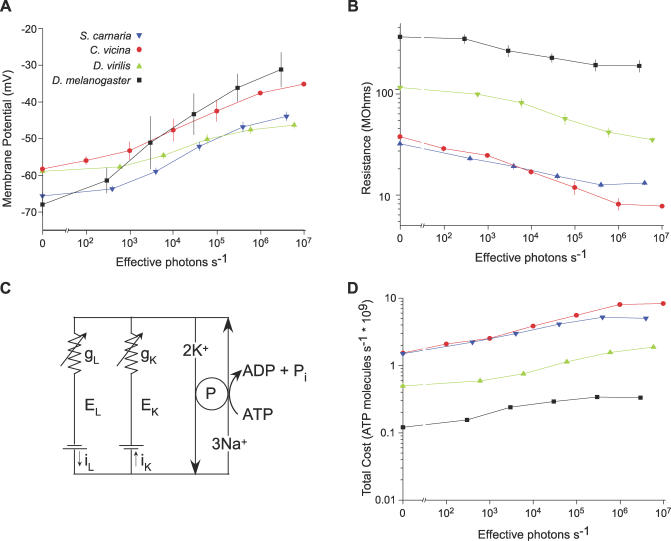
Measurements of Photoreceptor Membrane Properties Allow the Calculation of Metabolic Cost(A) The membrane potential (mean ± standard error of the mean) of R1–6 photoreceptors in the dark and at different effective photon rates, measured in four species S. carnaria (blue), C. vicina (red), D. virilis (green), and D. melanogaster (black).(B) The corresponding resistances (mean ± standard error of the mean) of R1–6 photoreceptor in the dark and at different effective photon rates.(C) The electrical model circuit of the photoreceptors. The model calculates from the measurements of membrane potential and resistance the rate at which the Na+/K+ pump, P, hydrolyses ATP molecules: g
L = light-gated conductance; E
L = reversal potential for light-gated current; i
L = light-gated current; g
K = potassium conductance; E
K = potassium reversal potential; i
K = potassium current.(D) The rate of hydrolysis of ATP molecules calculated at each effective photon rate for R1–6 photoreceptor of the four species (mean).